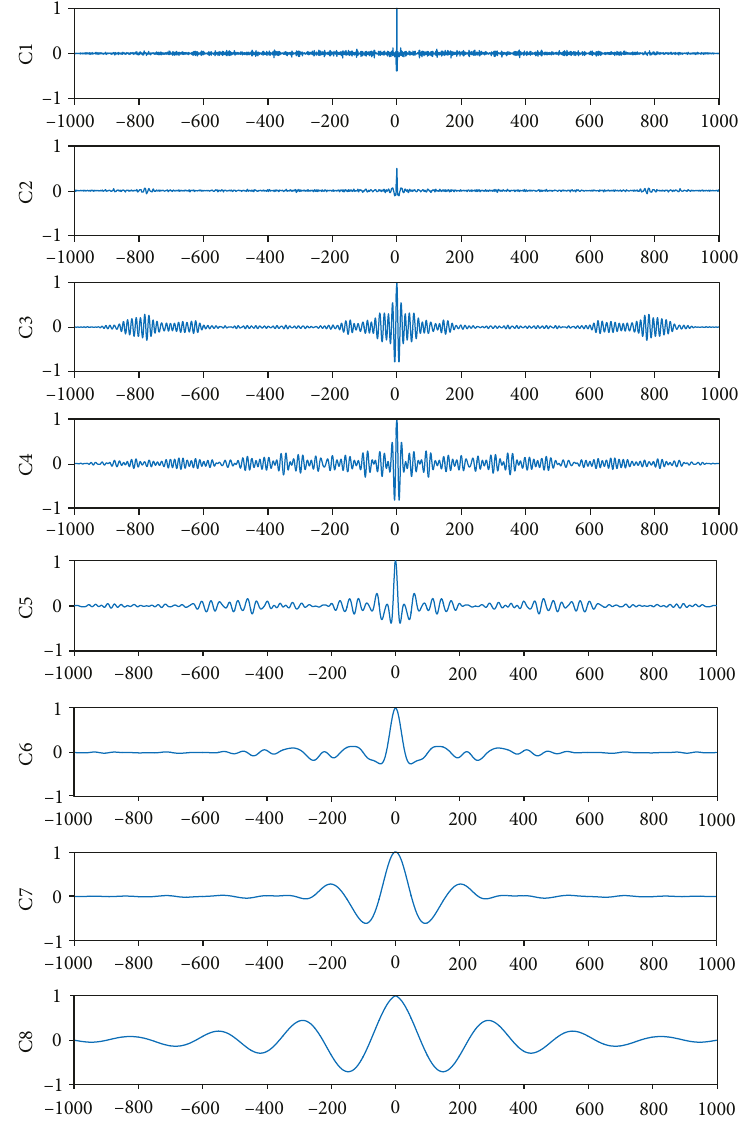
Figure 6: Sea clutter decomposition based on algorithm combined CEEMD with wavelet transform on